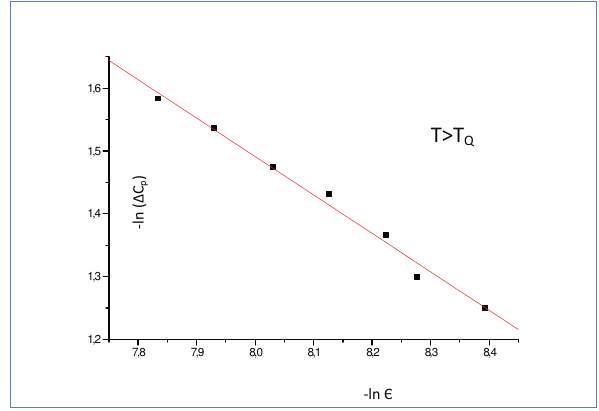
Figure 6. The specific heat (cid:3)C P as a function of the re- duced temperature ( (cid:4) D j T (cid:2) T Q j =T Q ) above the transi- tion temperature ( T Q D 577:1 ı C) for the ˛ - ˇ transition in quartz according to Eq. (2). The specific heat C P data [2] was used along the heating curve (see Table 3).